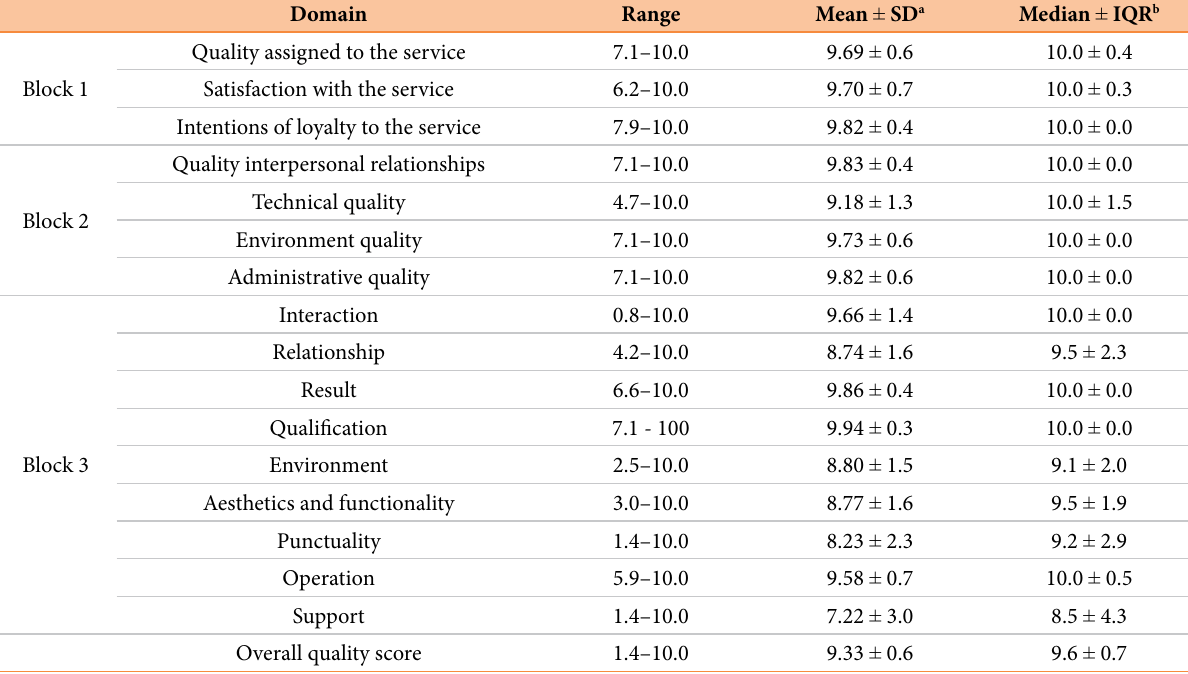
Table 2 – HSQS scores by domains (minimum satisfactory score: